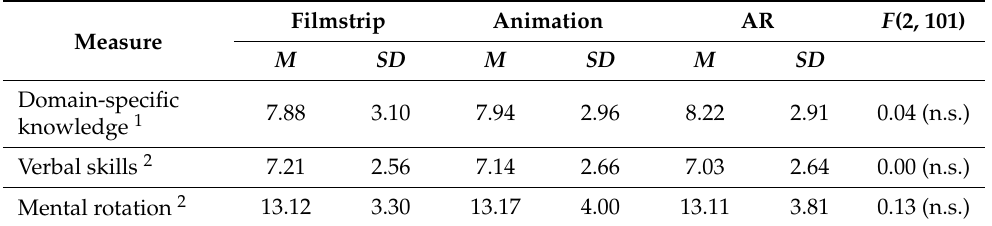
Table 2. Means, standard deviations and results of the one-way analysis of variance of relevant variables for grouping.